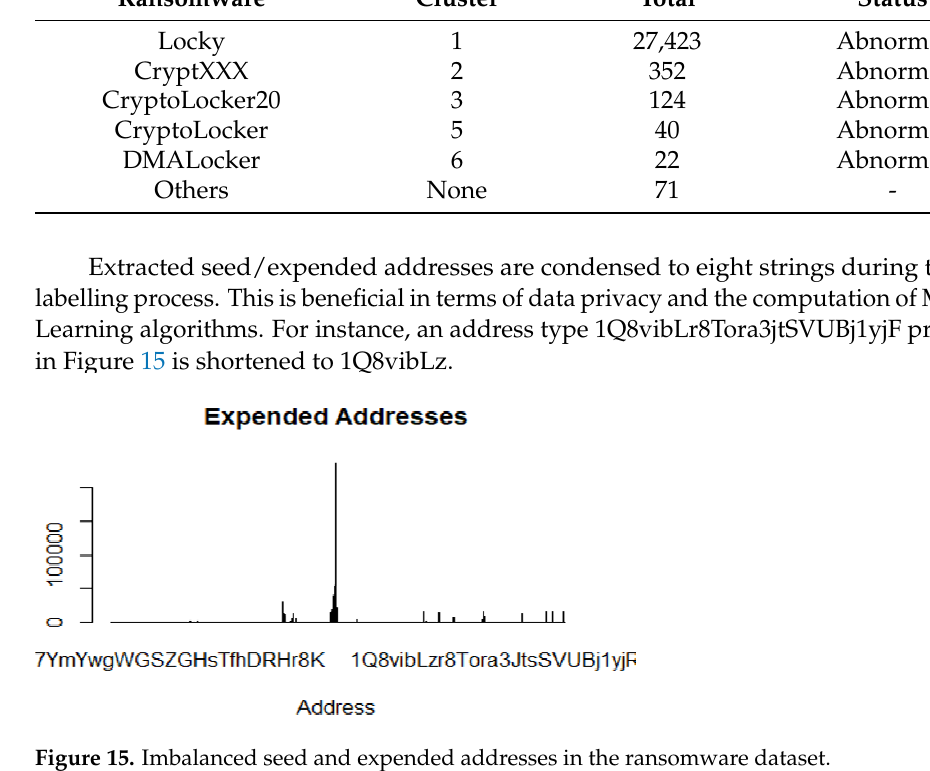
Figure 15. Imbalanced seed and expended addresses in the ransomware dataset. Results of the Feature Extraction reveals that the address type 1DA11mPS generates more financial damages (Figure